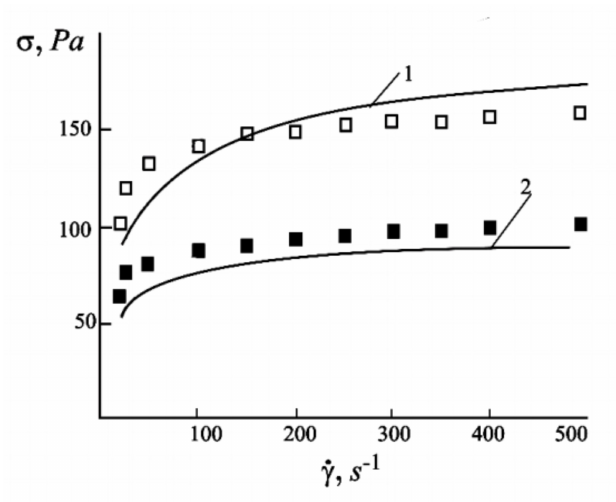
. γ Figure 13. Total stress σ versus the shear rate . Lines represent theoretical predictions and the dots represent experimental data: line 1 and open squares correspond to a field of 8.6 kA / m, while line 2 and filled squares correspond to a field of 5.7 kA / m. Adopted from [122]. Further details are given in [122].